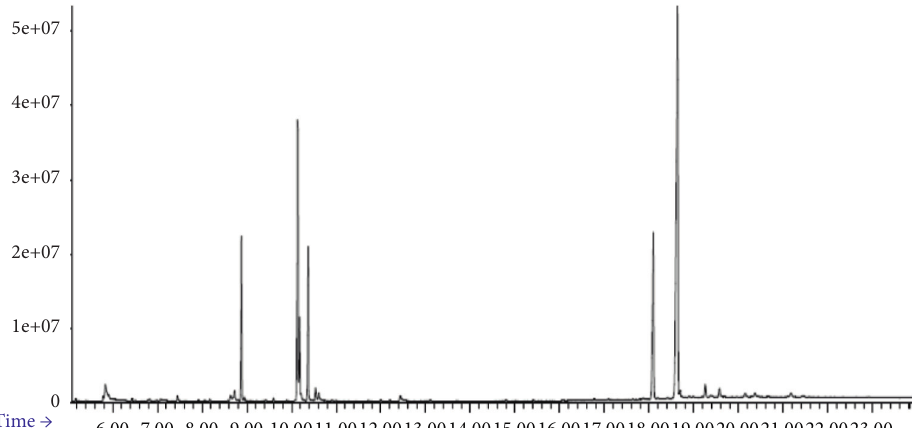
Figure 4: Chromatogram of Dittrichia viscosa L. essential